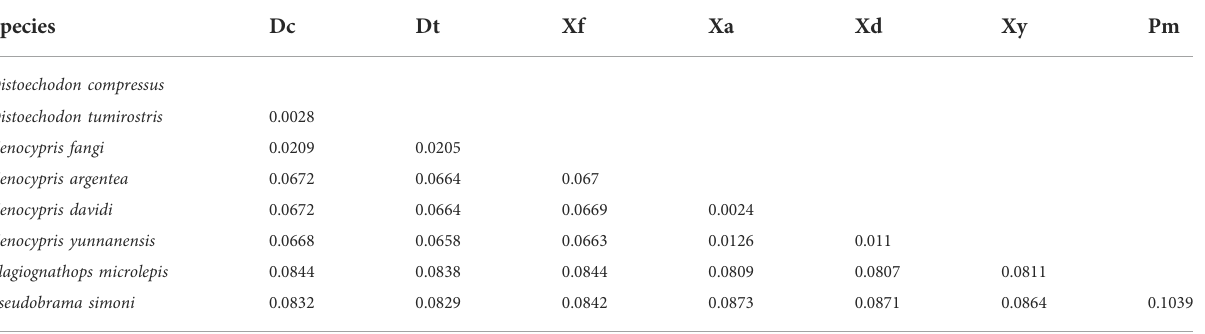
TABLE 2 Pairwise genetic distance between each two species within Xenocyprinae